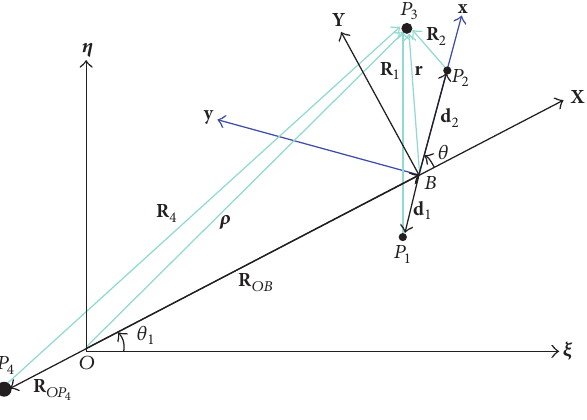
Figure 1: The configuration of